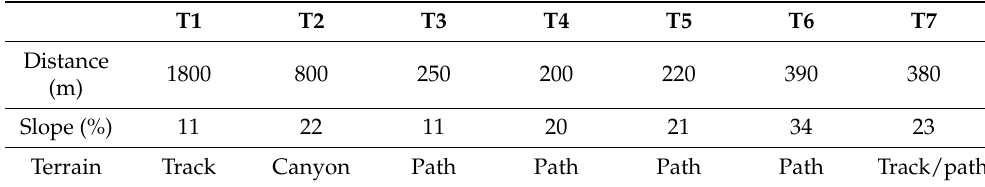
Table 1. Slope and horizontal distance of every section of the race besides the type of surface. T1 T2 T3